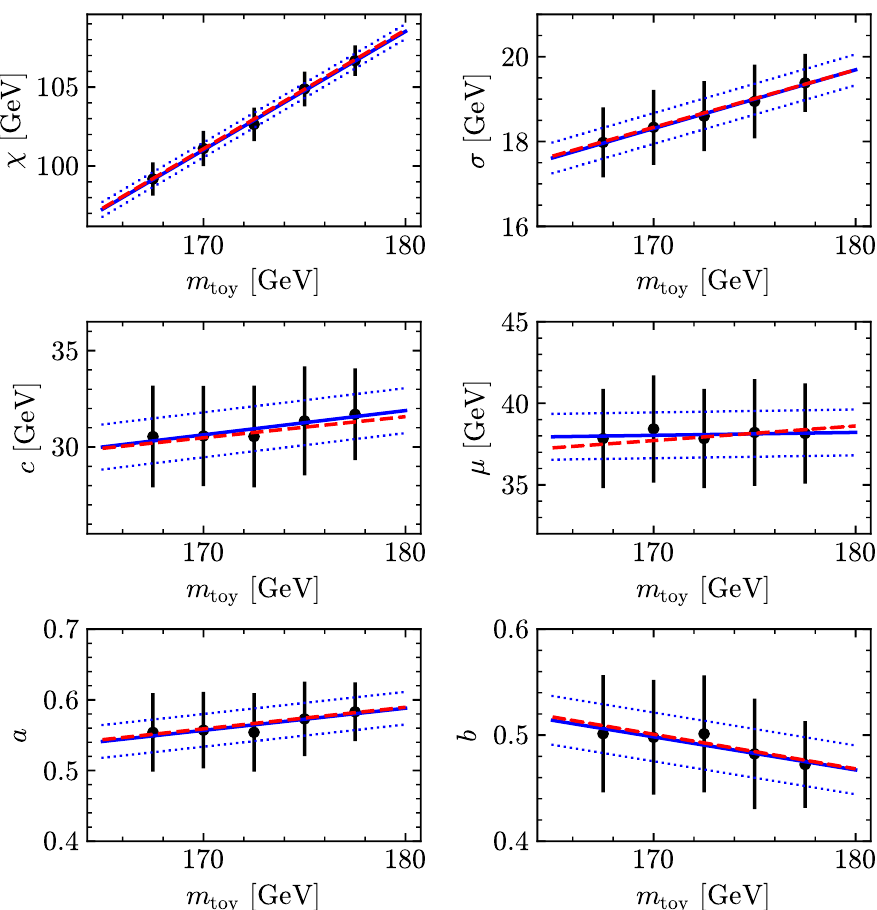
Figure 4 . The toy observable is (cid:12)t to the six-parameter function in eq. (2.3). We take the dependence of each parameter as a function of m toy from the red dashed lines. For each value of m toy , a dataset is drawn from these truth -level probability distributions, which is subsequently (cid:12)t to the function in eq. (2.3). This process is repeated 100 times; the black dots with error bars provide the mean and standard deviation inferred for each parameter. The blue solid lines give the resultant linear (cid:12)ts to these points with associated errors. The upper and lower dotted lines in each panel are the result of systematically shifting the best (cid:12)t line up and down by the covariance of the y -intercept as determined during the (cid:12)tting procedure (see section 2.1). The envelope of dotted